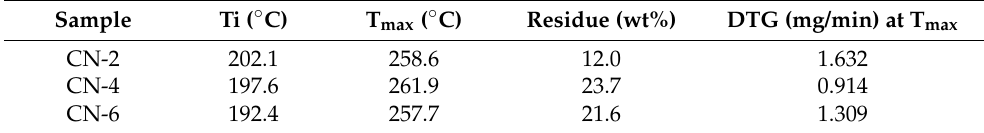
Table 3. Different thermal parameters for samples from TGA and DTG curves.